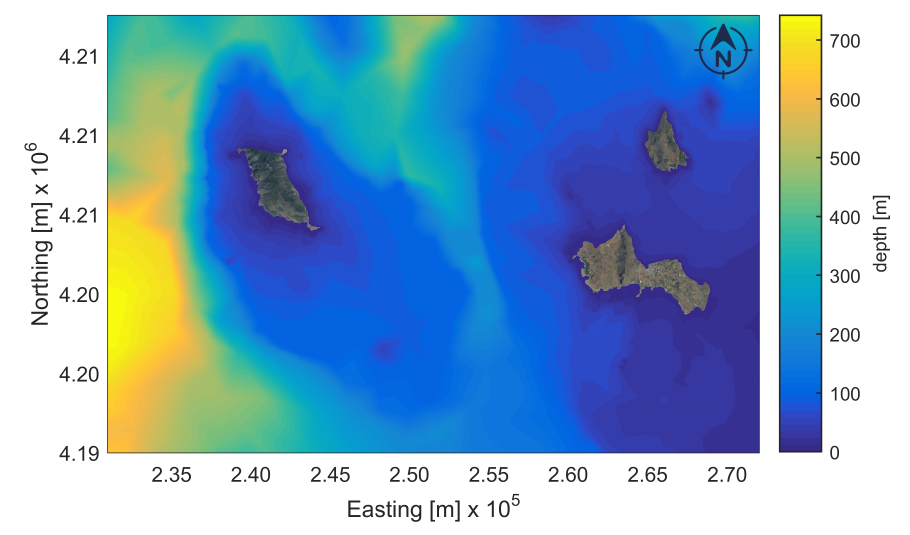
Figure 5. Bathymetry of the studied area. The colour bar shows the water depth in meters under the medium sea